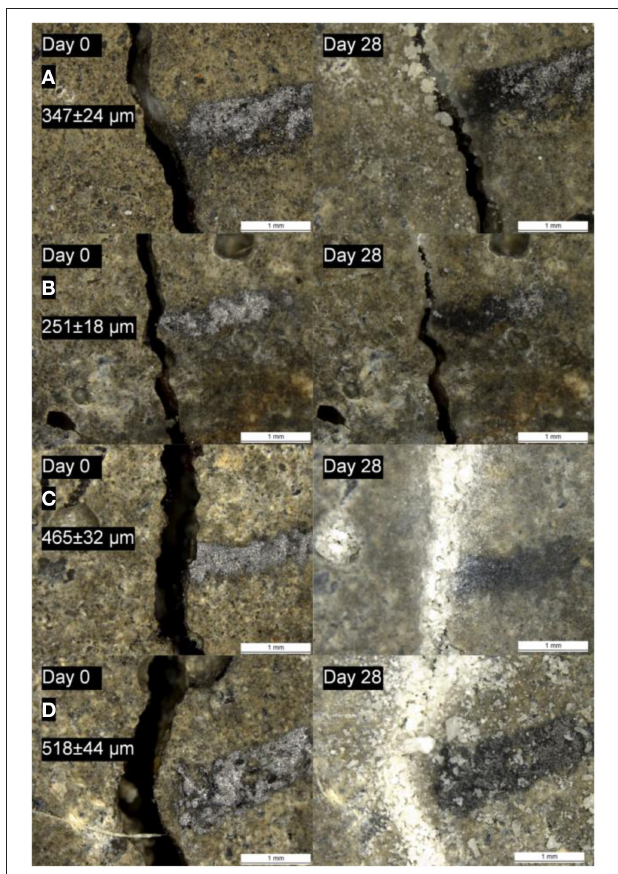
FIGURE 11 | The micrographs showing the initial (before incubation) and the final (after 28 days incubation) appearance of the cracks of the 6 months old specimens (A) reference specimen; (B) abiotic control (reference + 5% nutrients); (C) specimen with 0.5% ACDC and 5% nutrients; (D) specimen with 1% ACDC and 5% nutrients [Nutrients – 2% Ca(HCOO) 2 + 3% Ca(NO 3 ) 2 ; weight percentages are in terms of cement